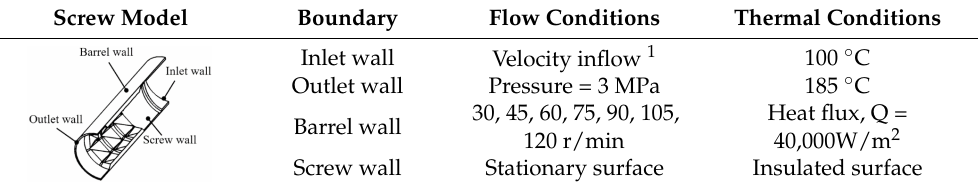
Table 3. Boundary conditions.